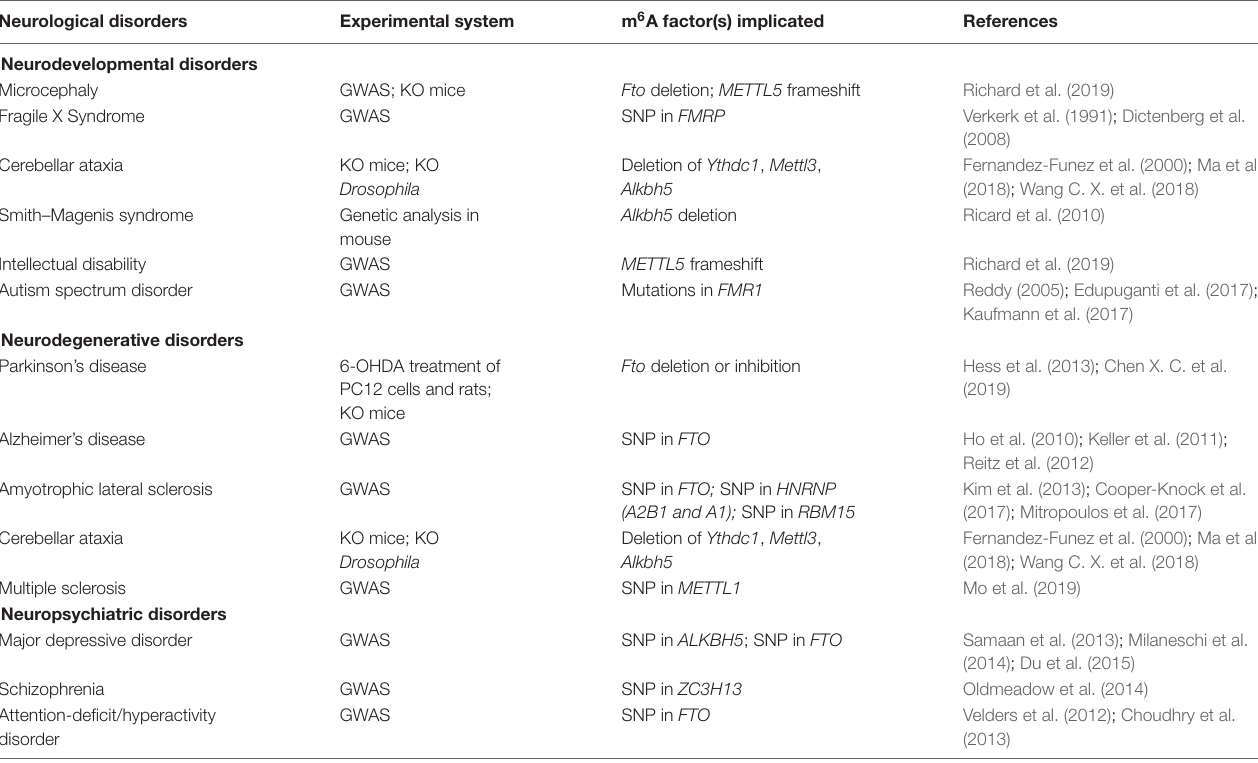
TABLE 2 | Brain disorders associated with m 6 A